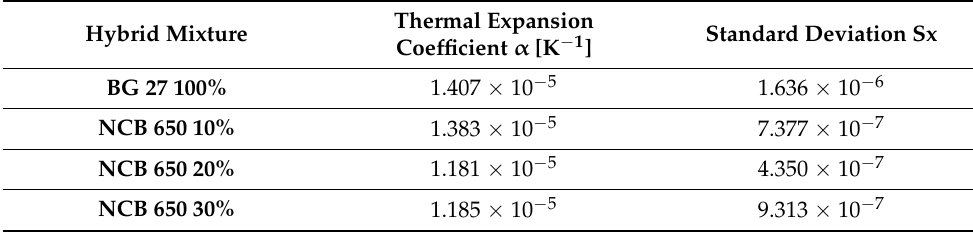
Figure 7. Comparison of thermal expansion coefficient of tested hybrid sands. Table 5. Comparison of thermal expansion coefficient of tested hybrid sands: results.